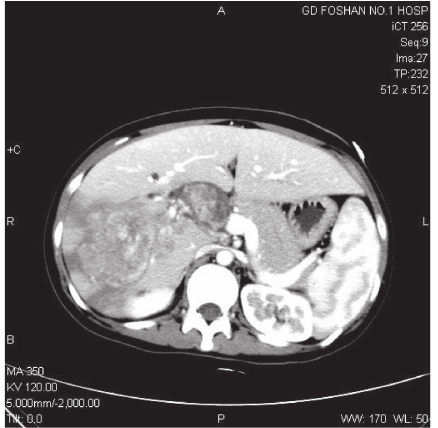
Figure 2: Biliary tumor thrombus at the right posterior sectoral duct, common hepatic duct, and common bile duct.